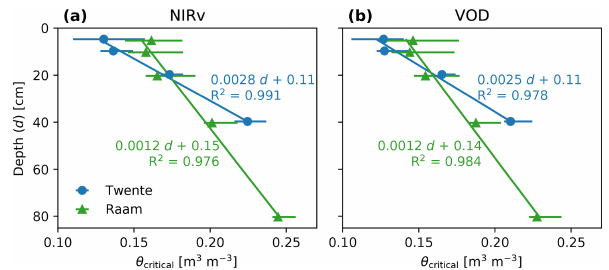
Figure 5. Relation between critical soil moisture and the integra- tion depth (denoted as d in the equation) of soil moisture used in the inference. Panel (a) shows the relation based on the NIRv data, and (b) shows the relation based on the VOD data. Horizontal lines indicate the 5%–95% range of critical soil moisture